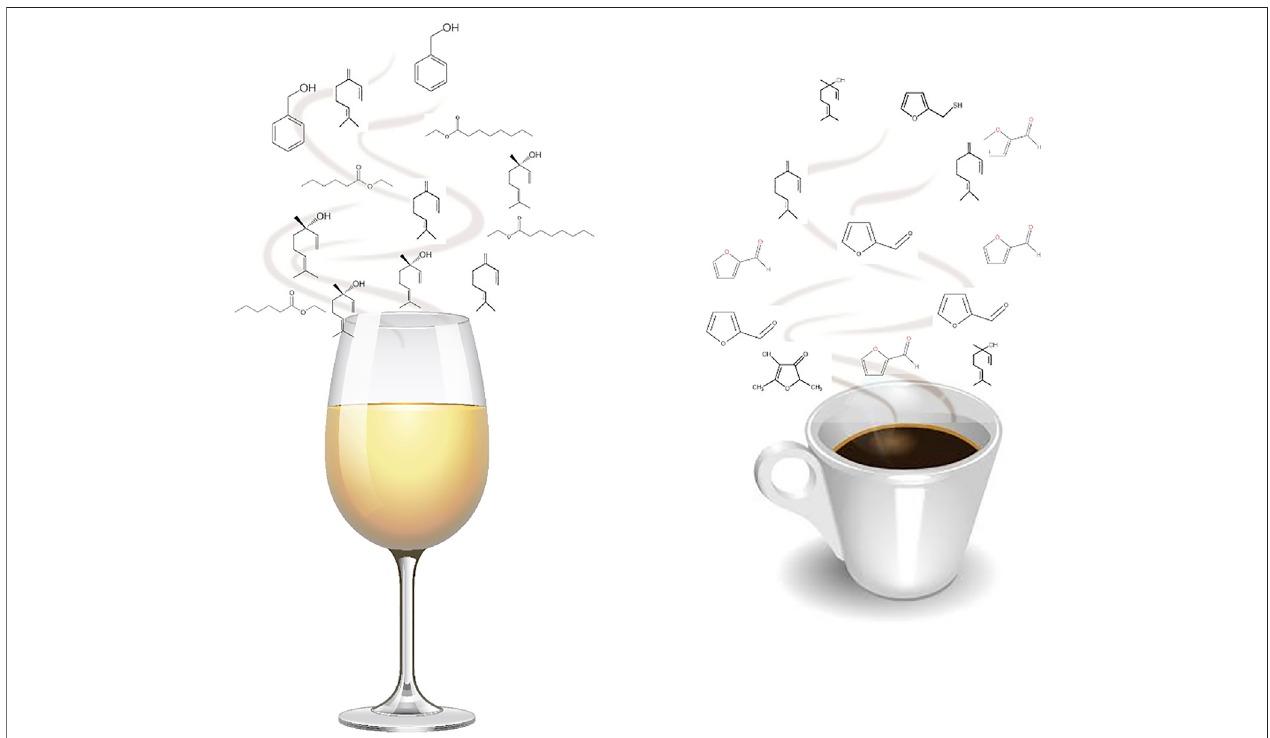
FIGURE1| Aroma clouds offoods: aset ofodorant volatile and semi-volatile molecules, released fromfoods,namelyfrom liquid, solid,paste,or others, whichare responsible for their aroma properties, here illustrated with white wine and espresso.